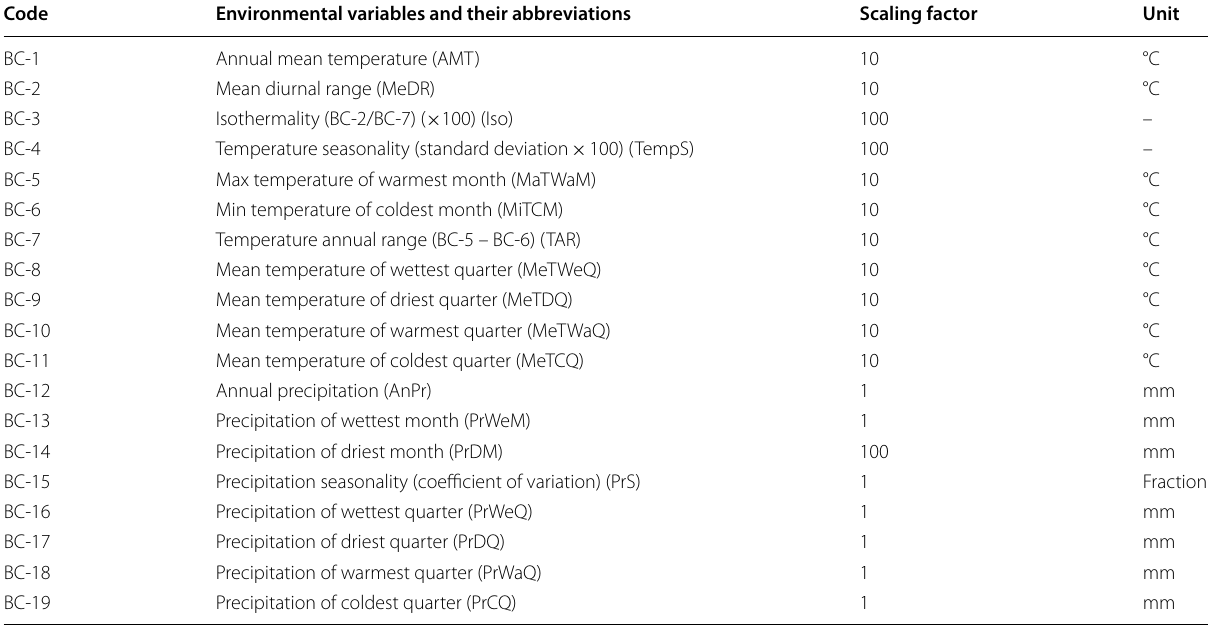
Table 1 Description of predictive bioclimatic variables used in this study (downloaded from WorldClim related to four time frames: current, 2050, 2070 and 2090 of Shared Socioeconomic Pathways (SSP2-4.5